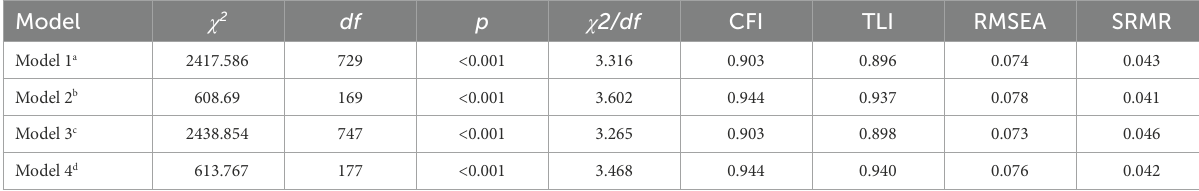
TABLE 3 Results of four CFAs ( n = 427).